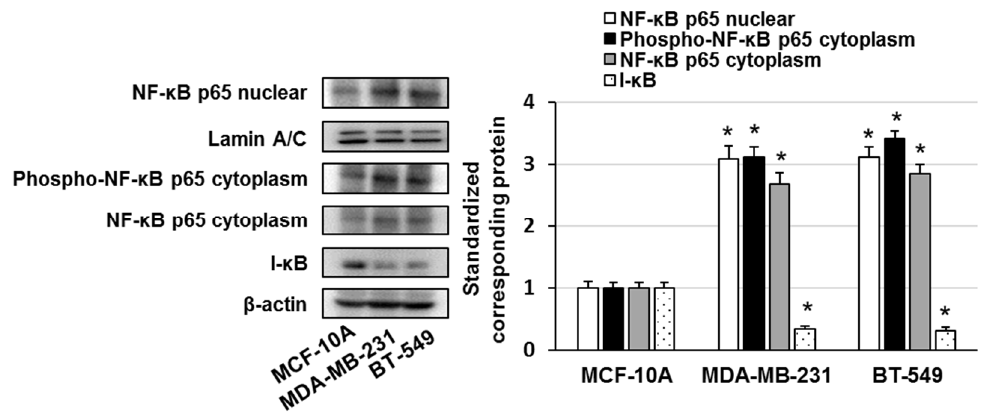
Figure 2. Cell lysates were evaluated by immunoblotting using the shown antibodies. The content of nuclear NF- κ B p65, cytoplasmic phospho-NF- κ B p65, cytoplasmic NF- κ B p65, and I- κ B was quantified and standardized to the content of Lamin A/C or β -actin. The results are representative of three independent experiments. * p < 0.01 vs. untreated cells.